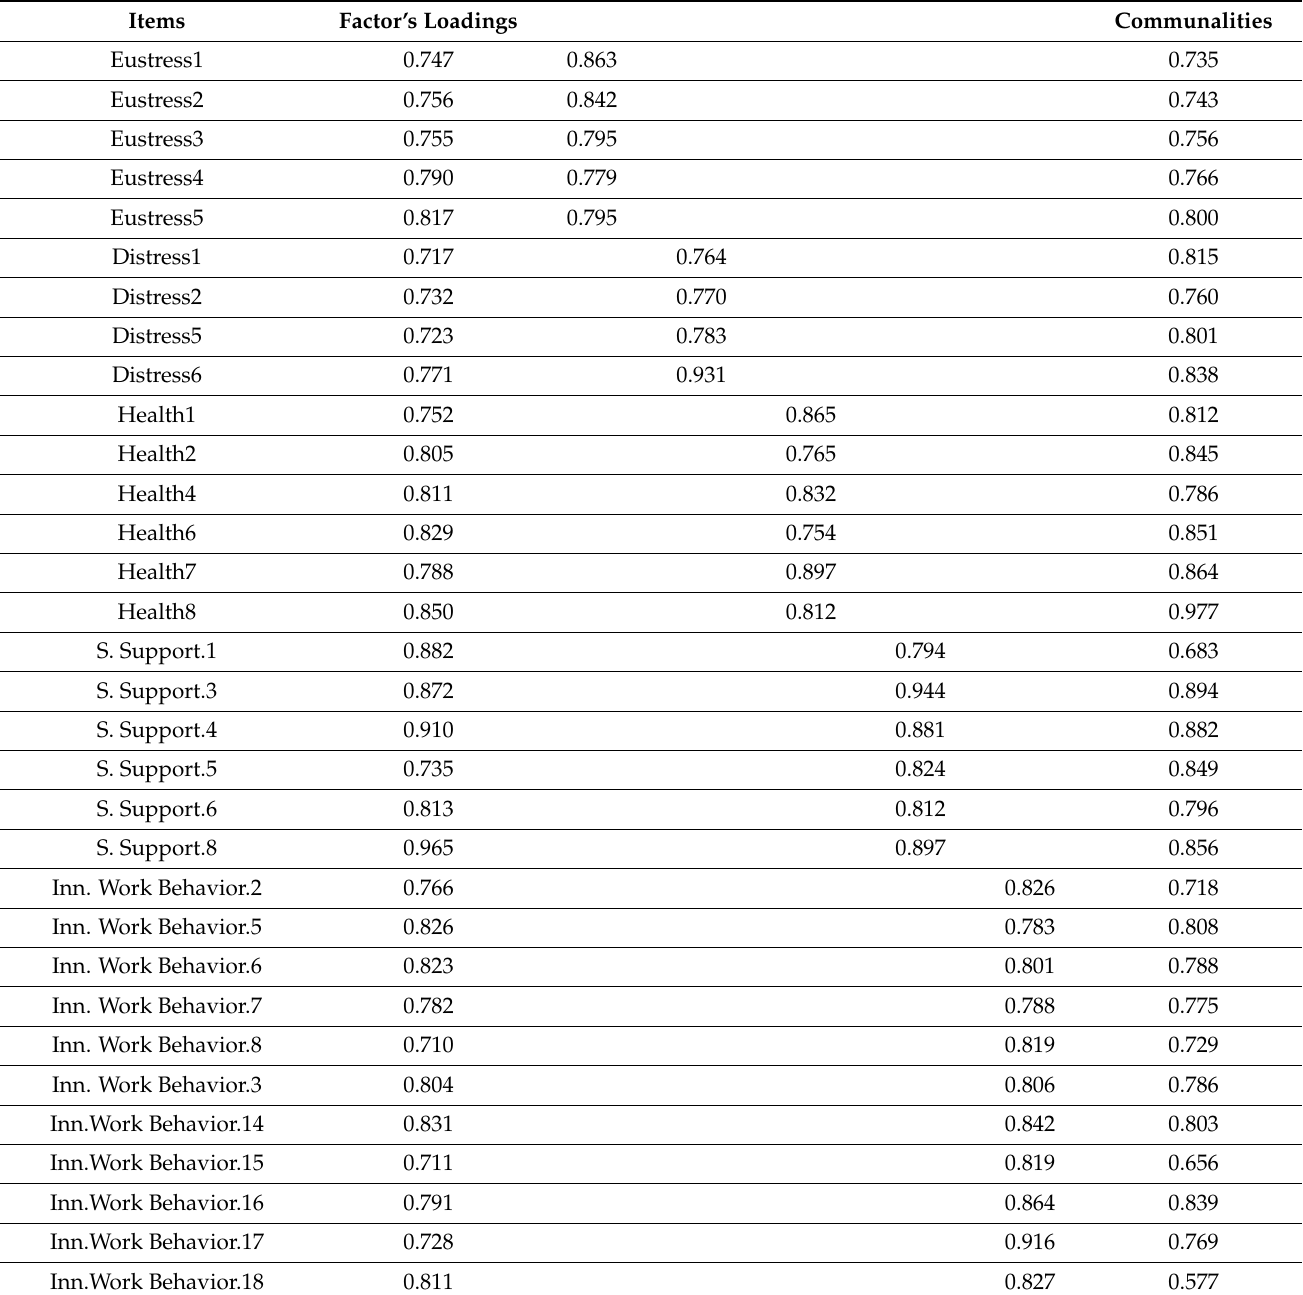
Table 4. Factor Loadings, Pattern Matrix, and